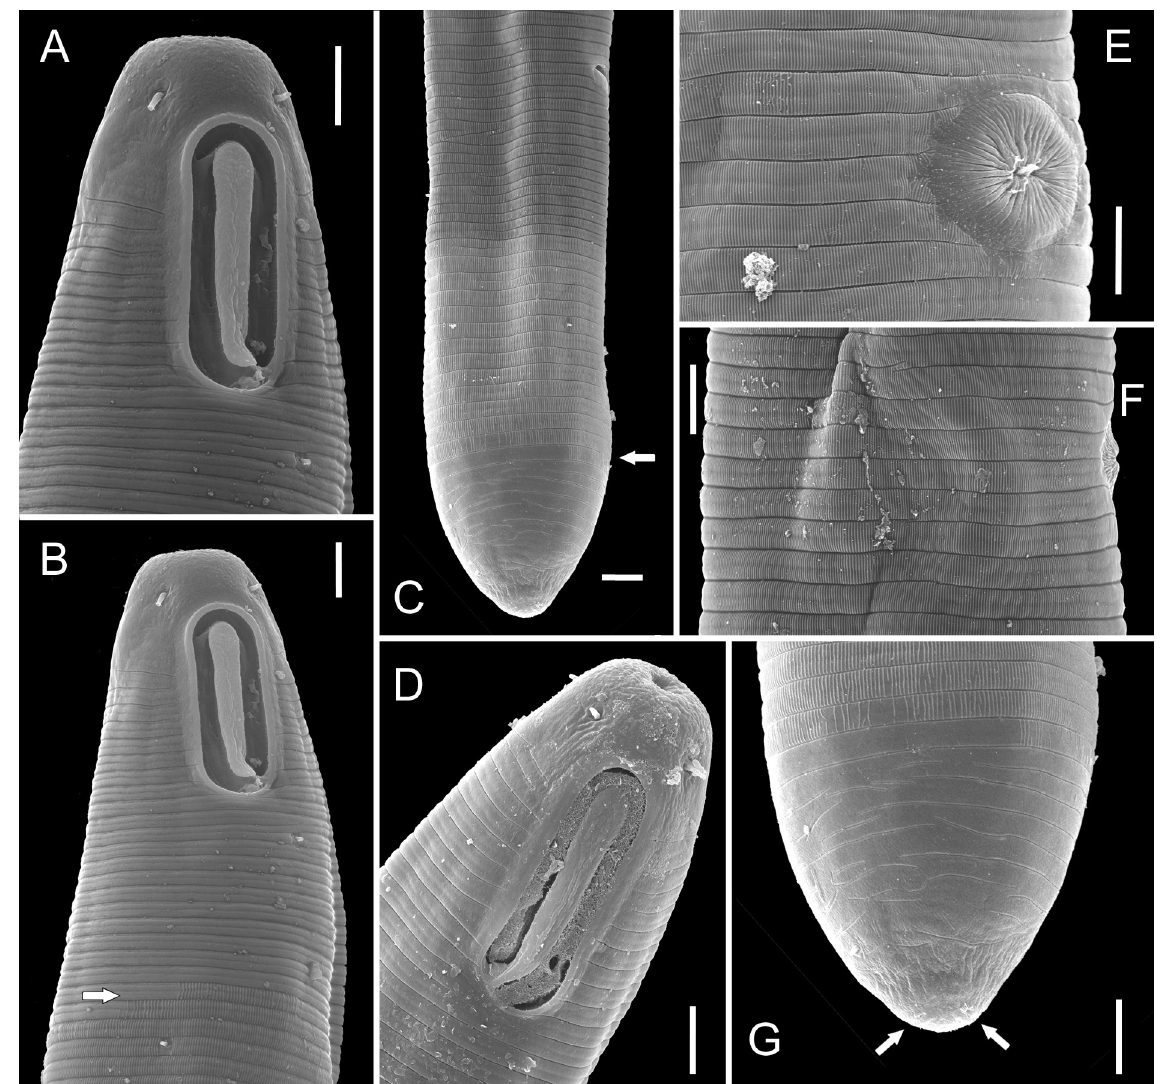
Fig. 6. Diplopeltoides bulbosus (Vitiello, 1972) comb. nov. SEM micrographs of females. A–B . Anterior end, right sublateral view (arrow points at the anterior edge of longitudinal striation of cuticle). C . Female tail (arrow points at the posterior edge of the longitudinal striation of the cuticle). D . Anterior end, left sublateral view. E . Vulval region, ventrosublateral view. F . Vulval region, lateral view. G . Tail terminus (arrows point at openings of caudal glands. Scale bars: A–G = 5